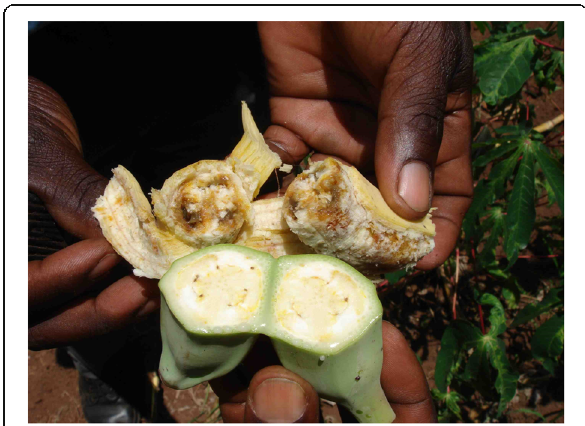
Fig. 1 Rotting banana fruit caused by the bacterial phytopathogen Xanthomonas campestris pathovar musacearum in Uganda. The disease (banana Xanthomonas wilt) also causes wilting and death of banana plants and significant reductions in availability of this staple food in East and Central Africa (source S. Miller)